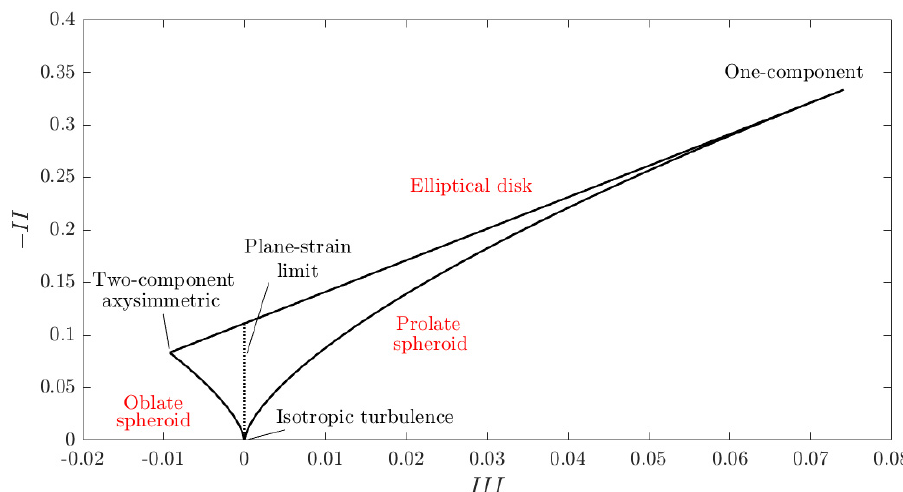
Figure 6. Conceptual diagram of the anisotropy invariant map.